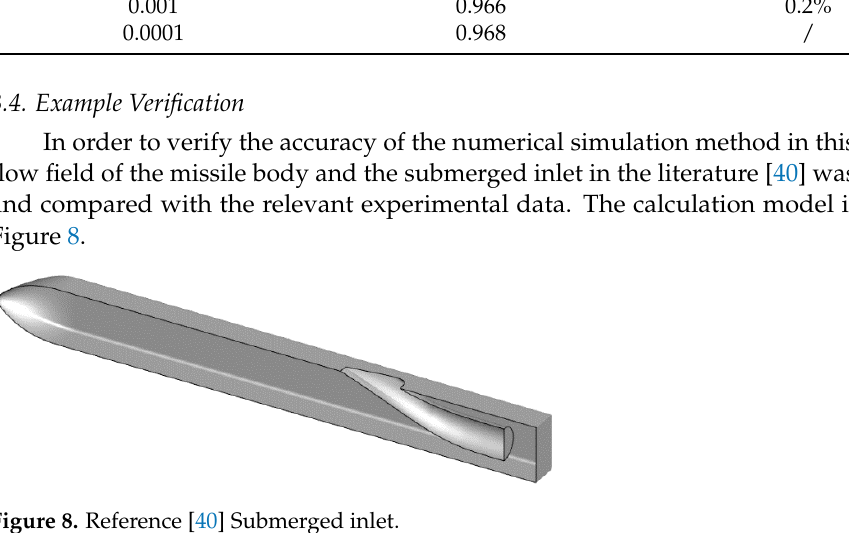
Figure 9. Local mesh of missile body surface and inlet. The calculation conditions are set according to the experimental conditions in the